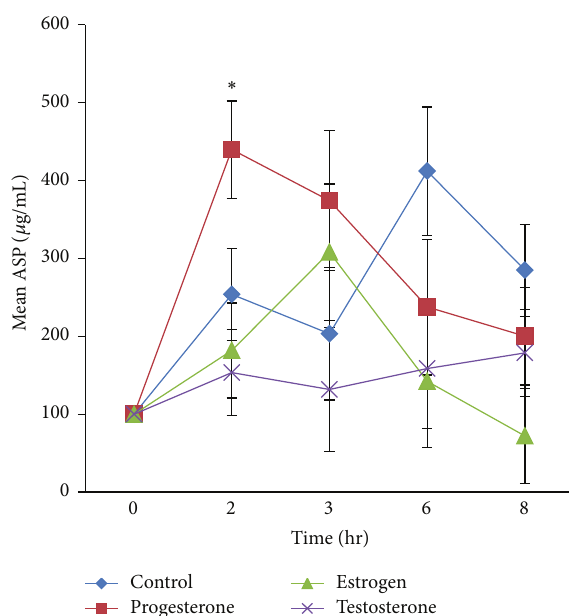
Figure 1: Changes in plasma ASP concentrations after an oral fat load for different hormone treated groups and control group (each group, 𝑛 = 6 ). Results at each time point during postprandial period are expressed as means ± SEM ( 𝜇 g/mL) of difference in ASP levels from basal (by subtracting basal value at time zero (as shown in Table 2)) from each time point, and percentage increase was calculated. Two-way RM-ANCOVA demonstrated a significant main interaction between hormone treatment and time (hormone treatment × time); 𝐹 = 2.04 , 𝑃 = 0.033 , and partial eta squared = 0.25. Significant changes were set at ∗ 𝑃 < 0.05 , basal ASP levels.